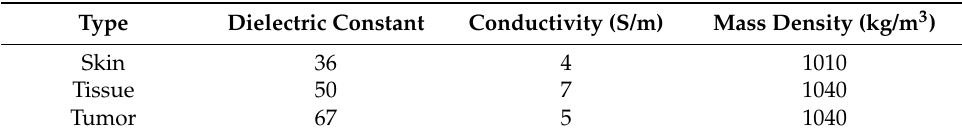
Table 5. Dielectric properties of the skin, tissue, and